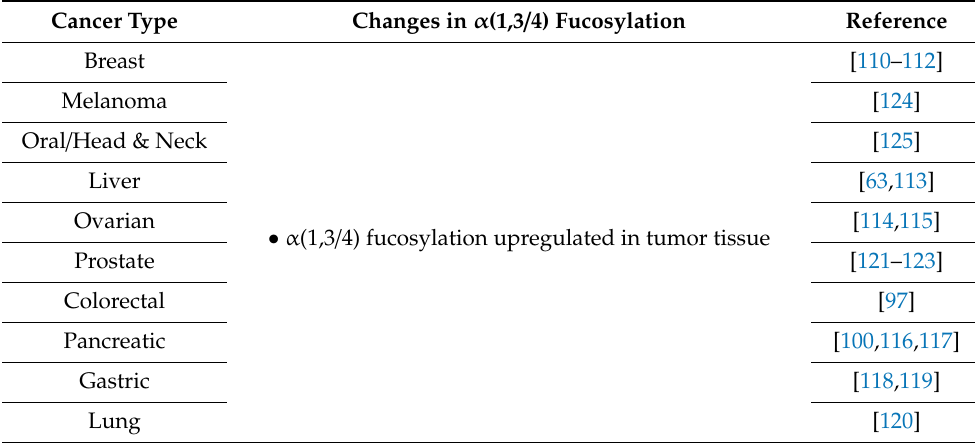
Table 5. Alterations of α (1,3 / 4) fucosylation